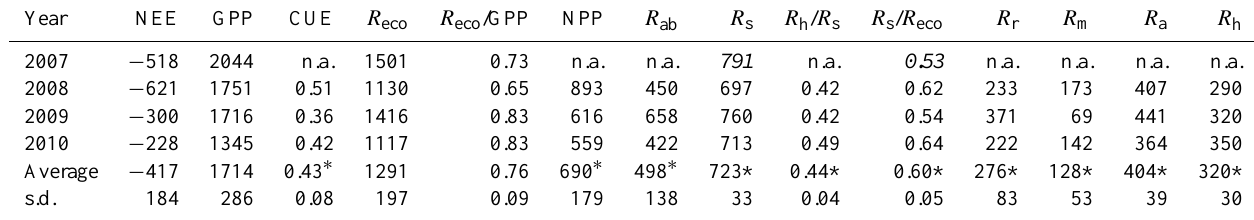
Table 3. Annual ecosystem C flux sums at the Straits Enclosure, Alice Holt forest, (in gCm − 2 ; calculated from daily values) and C flux ratios for 2007 to 2010. NEE is net ecosystem CO 2 exchange with uptake shown as negative values, GPP is gross primary productivity, R eco is ecosystem respiration, NPP is net primary productivity, and CUE is carbon use efficiency = NPP/GPP. Total soil respiration, R s , included replacing missing values due to late start of monitoring or system failure by values from a temperature regression (shown in italics for yearly sums; n.a. denotes no data available). Separation of R s components only occurred from 2008: autotrophic ( R a , sum of root, R r and mycorrhizal hyphal respiration, R m ) and heterotrophic ( R h ) respiration. The annual NPP was calculated as GPP − ( R ab + R a ) , where R ab is above ground respiration (i.e. R eco − R s ) ; * denotes that averages for soil flux components and respective ratios only reflect 2008–2010 data.